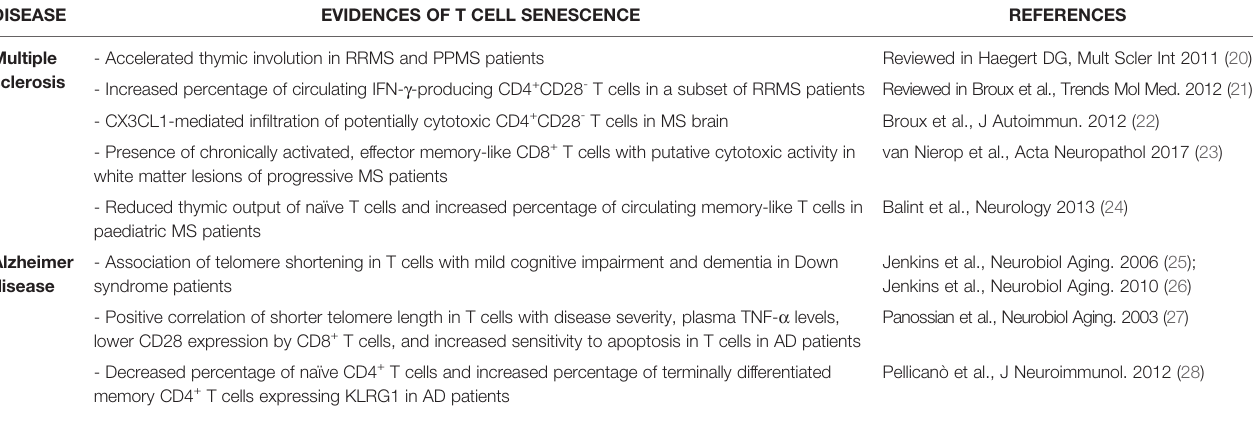
TABLE 1 | Summary of previous works suggesting the presence of senescent T cells in MS and AD patients.